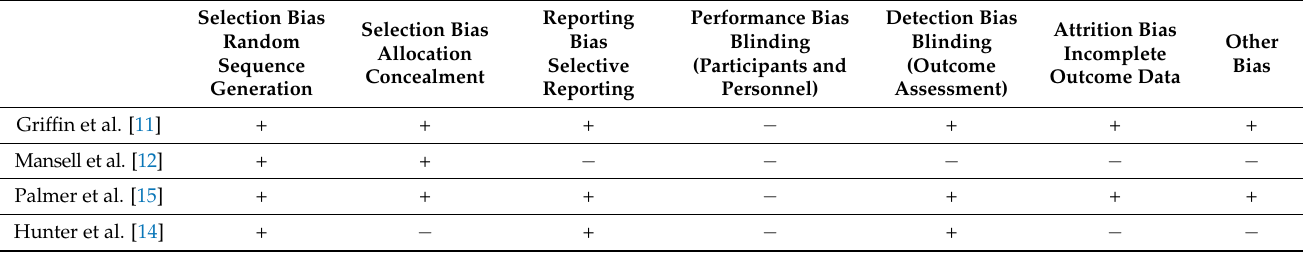
Table 2. Cochrane Risk of Bias assessment for all the included studies. + Low risk of bias; − High risk of